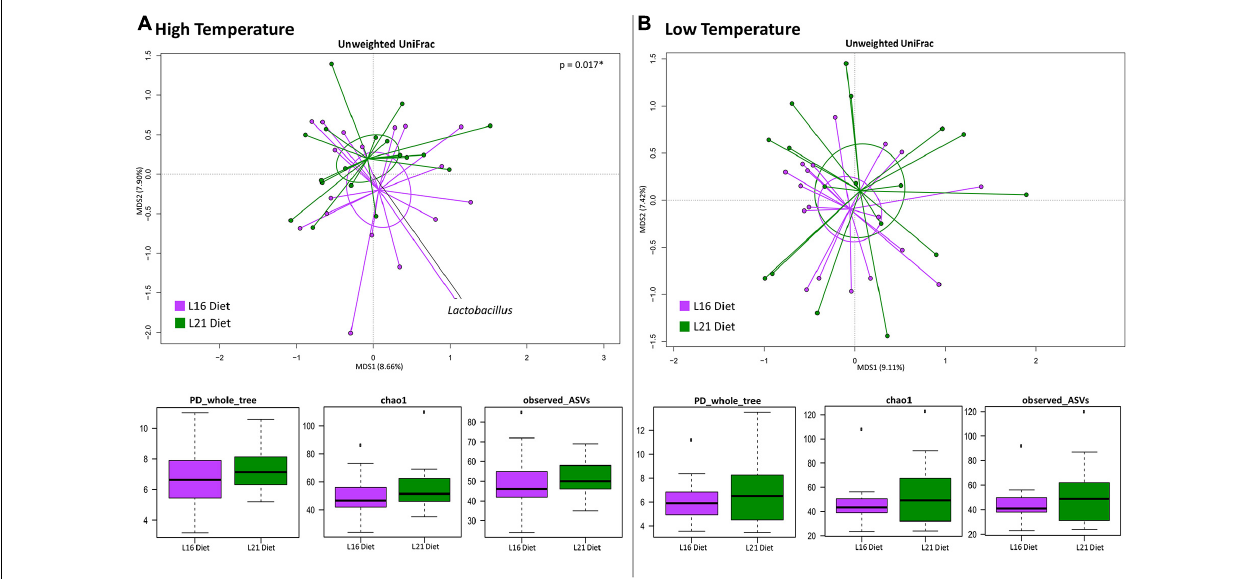
FIGURE 3 | Beta diversity and alpha diversity of gut microbiota of gilthead sea bream fed with the experimental diets at both warm and cold temperatures. (A) PCoA based on unweighted UniFrac distances between gut microbiota structure of animals fed with L16 and L21 diets and grown at warm temperature. Samples are significantly separated (permutation test with pseudo-F ratios Adonis; p = 0.017). (B) PCoA based on unweighted UniFrac distances between gut microbiota structure of animals fed with L16 and L21 diets and grown at cold temperature. Samples are not significantly separated (permutation test with pseudo-F ratios Adonis; p > 0.05). Black arrows are obtained by fitting the genus relative abundance values for each sample within the ordination space (function envfit of the vegan R package, with a p -value < 0.01). For both temperature conditions, all metrics used to assess alpha diversity did not show a significant variation between the two experimental diets (as highlighted by the boxplots in both panels). L16, low-lipid 16% diet; L21, high-lipid 21% diet.